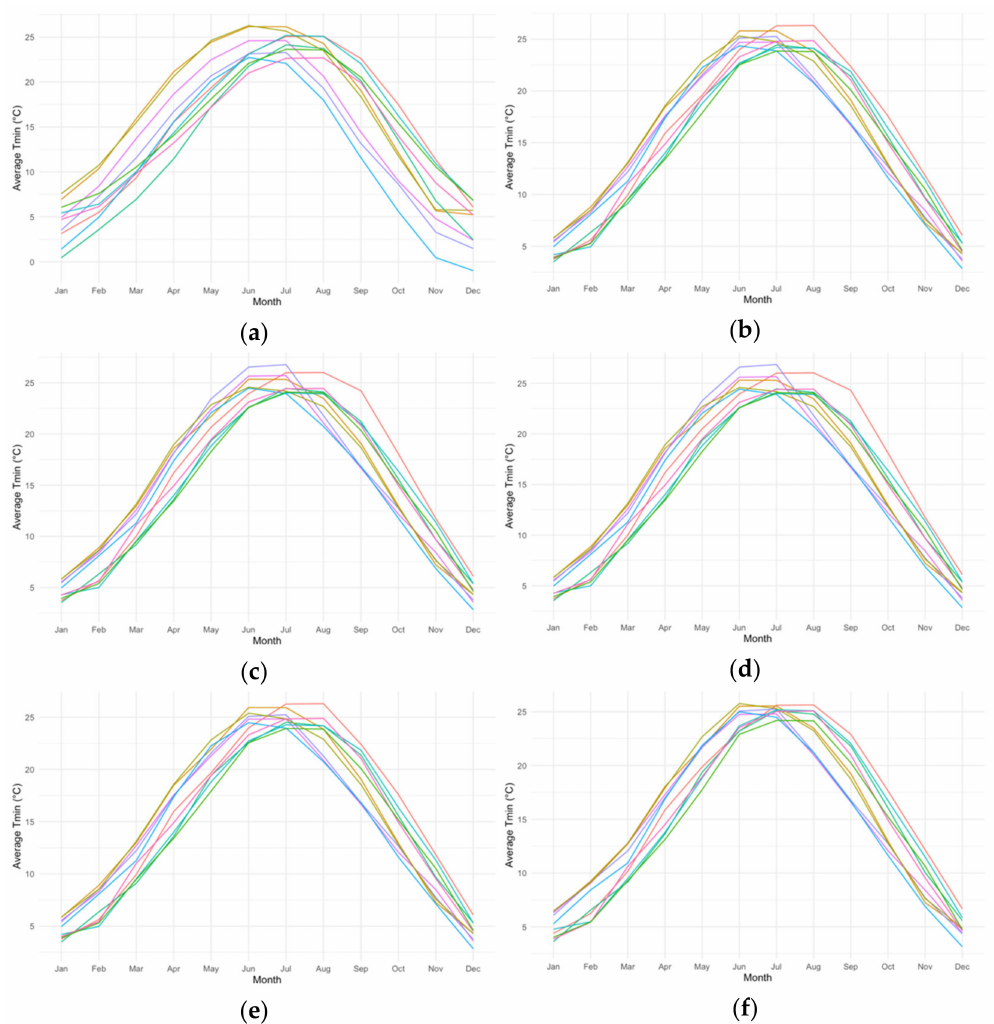
Figure 1. Monthly average minimum temperature in Atlanta (2051–2099) for 10 climate models with and without different quantile mapping bias-correction methods. Each color indicates a different GCM and RCM combination from NA-CORDEX. ( a ) Future monthly mean without correction; ( b ) Future monthly mean by linear QM; ( c ) Future monthly mean by empirical QM; ( d ) Future monthly mean by robust QM; ( e ) Future monthly mean by normal mapping; ( f ) Future monthly mean by